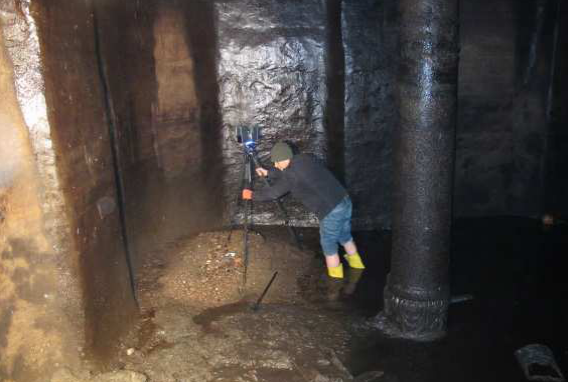
Figure 10-b.Level of the mud and water on time of scanning The results of filtering and smoothing steps have been evaluated. For this, 30 reference control points on the mesh